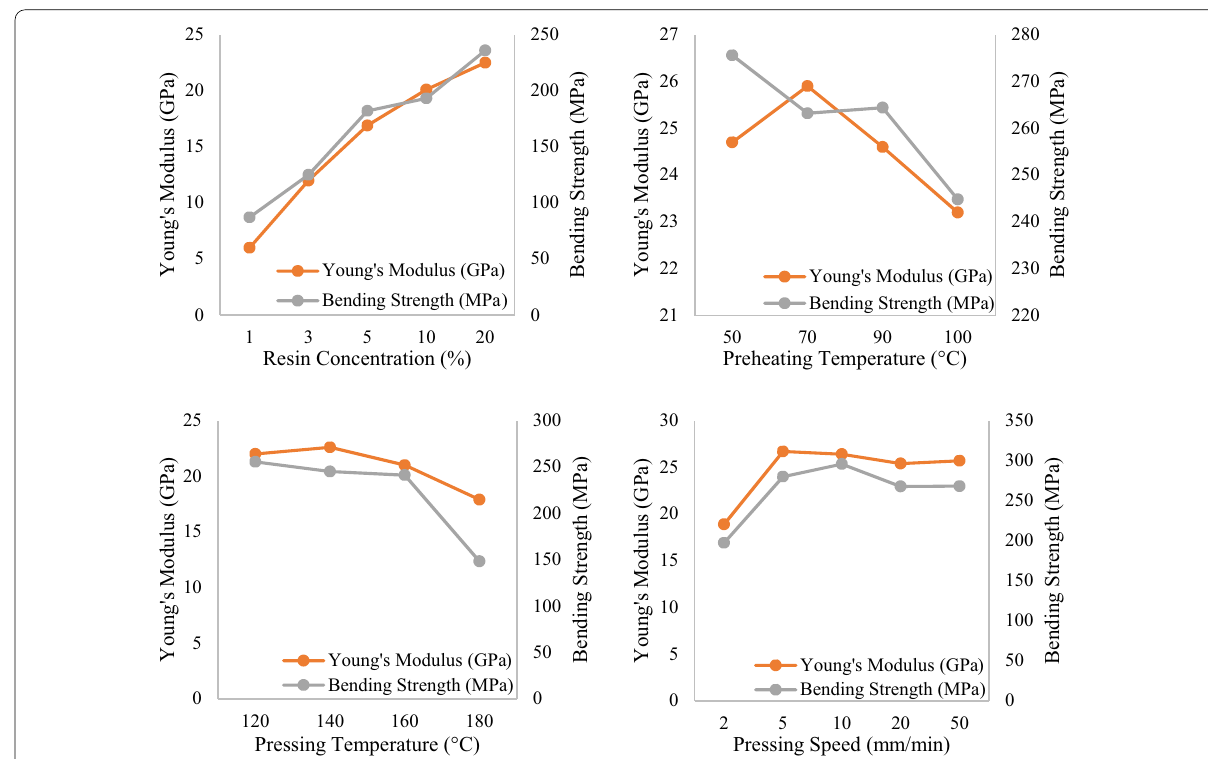
Fig. 8 Analysis of trends observed in the mechanical properties of PF resin impregnated timber with different parameters